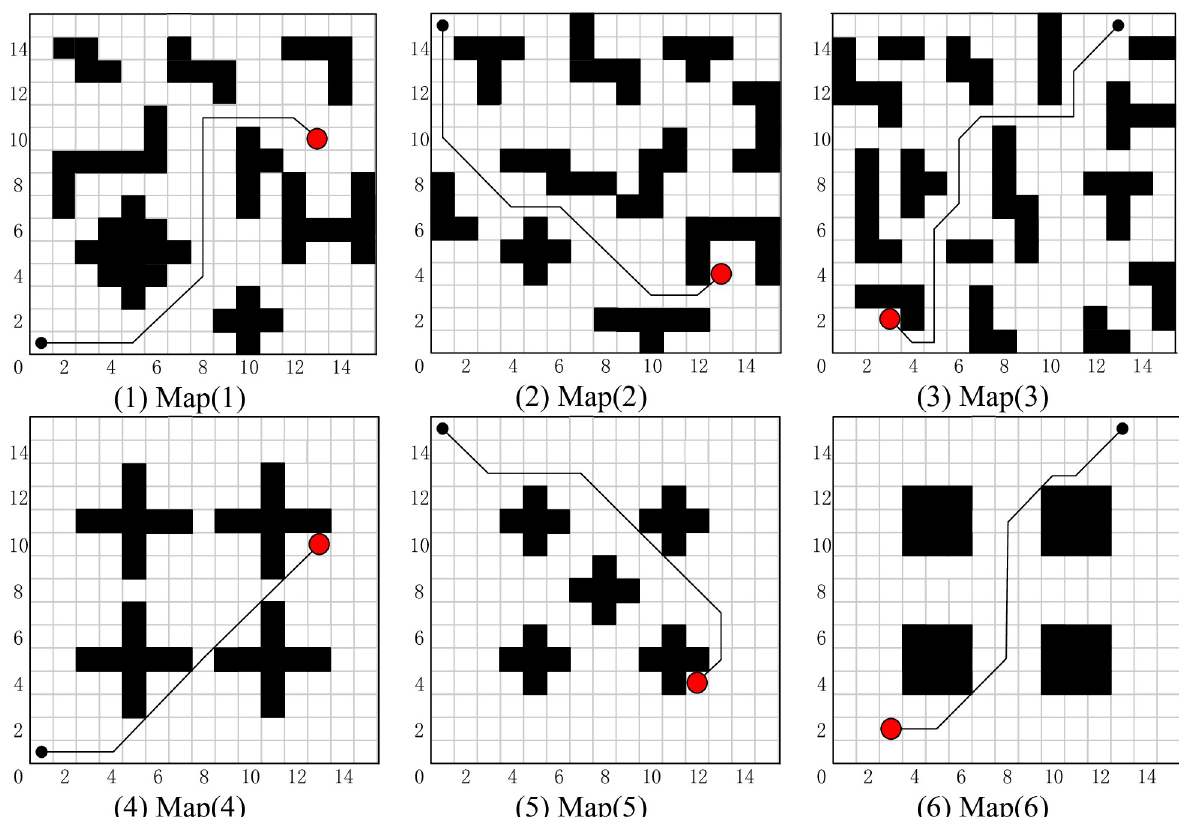
Fig 8. Typical grid map path planning for SAR robot in different environments.